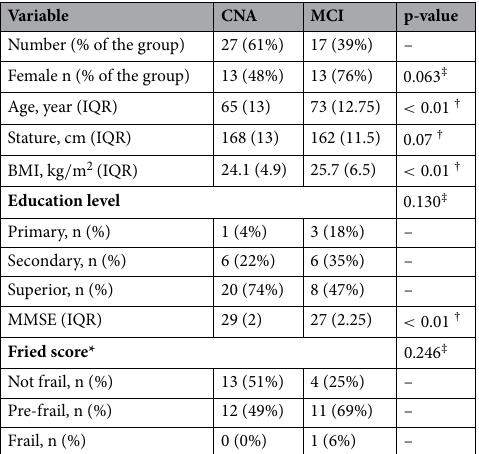
Table 1. The † symbol represents differences computed by the Mann–Whitney U -test. Whereas, the ‡ symbol represents differences computed by χ 2 test. BMI, body mass index; MMSE, mini-mental state examination; For each cognition group the median and the interquartile range (IQR) values are presented. *The Fried Index is based on the Fried frailty phenotype criteria, that has been administered to 16 Controls and 16